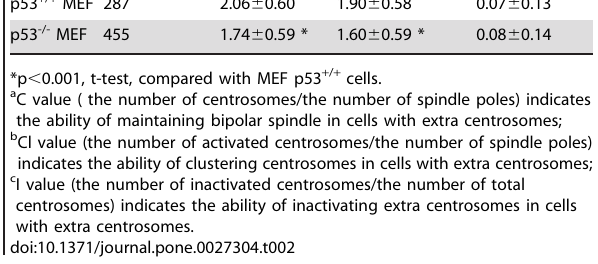
No. of cells analyzed % (Mean ± s.d.)